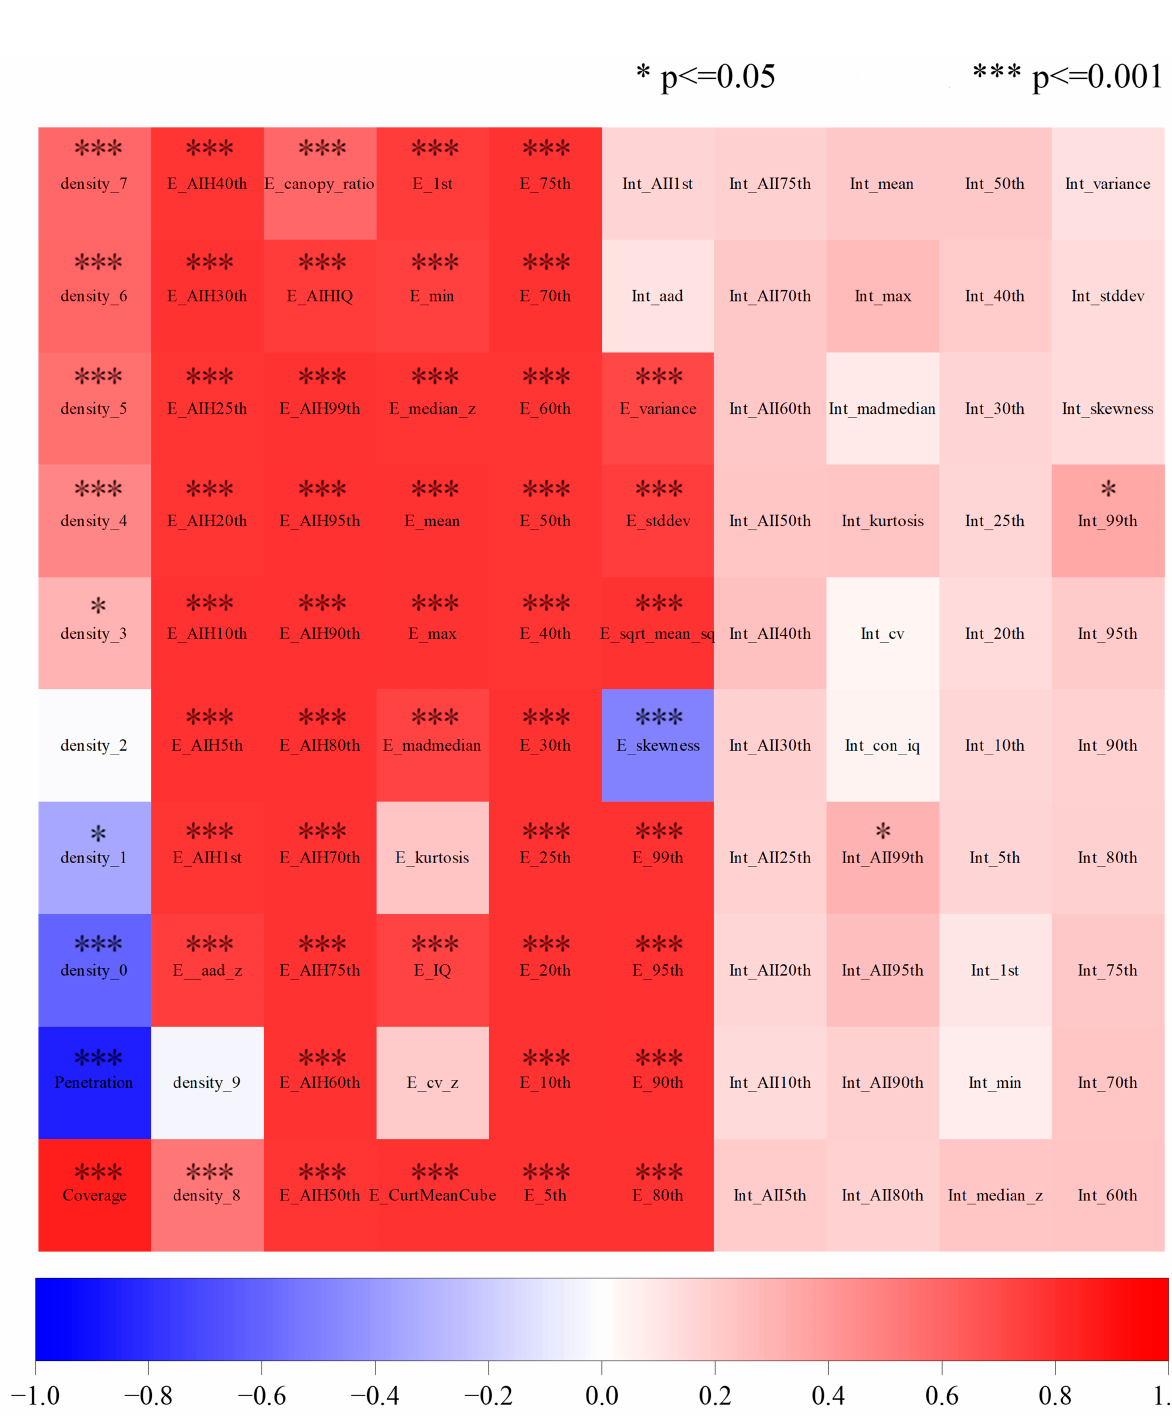
Figure 8. Pearson correlation diagram of the structural parameters and measured LAI.